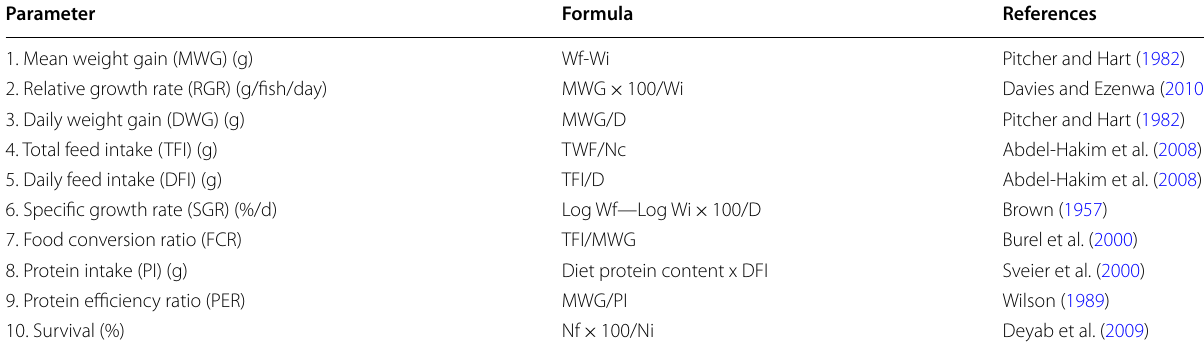
Wf, final weight of the fish; Wi, initial weight of the fish; D, rearing period; Nf, final number of fish at the end of the experiment; Ni, initial number of fish at the beginning of the experiment; TWF, total weight of feed fed; Nc, number of fish currently exposed; MWG, mean weight gain; TFI, total feed intake; DFI, daily feed